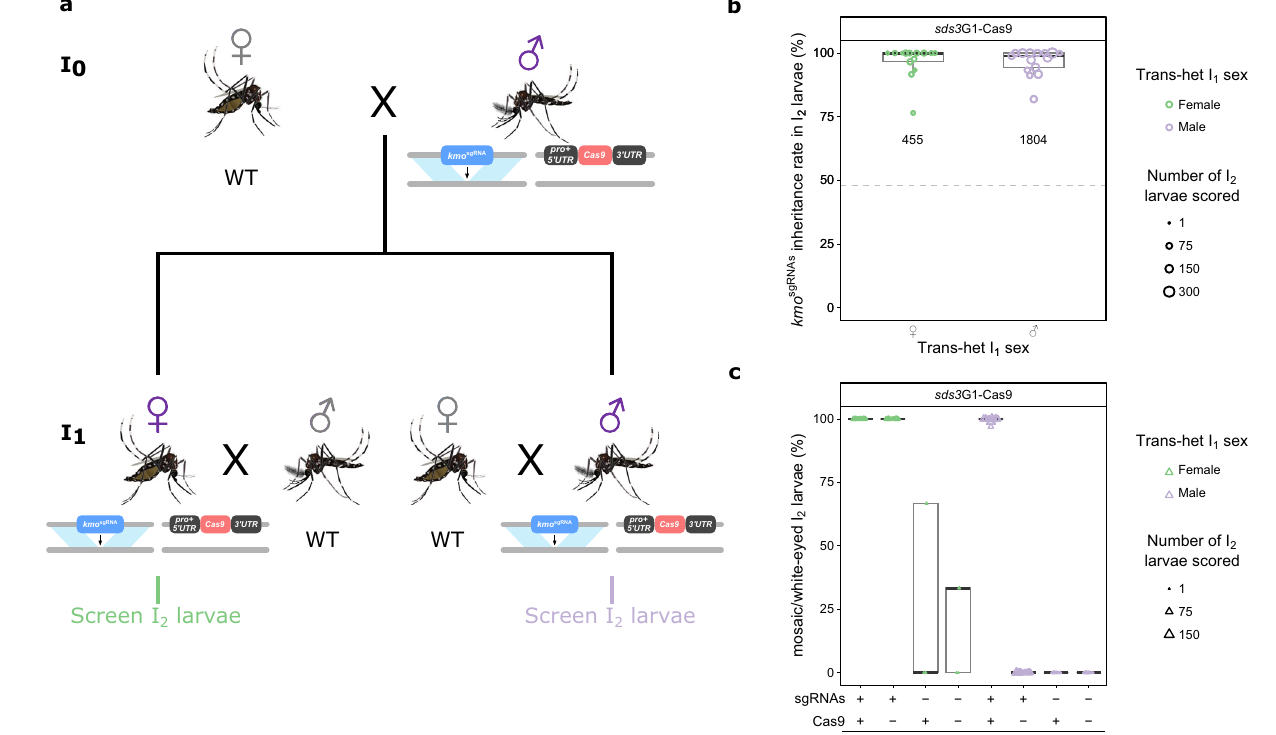
Fig. 3 | Drive characteristics of individual kmo sgRNAs ; sds3 G1-Cas9 trans-hetero- zygotes.a Crossing schemefordeterminationof sds3 G1-Cas9-inducedinheritance bias. b , c Boxplots of kmo sgRNAs inheritance ( b ) and eye phenotype ( c ) rates of I 2 larvae. The median value is indicated by a thick black line and the maximum and minimum ends of whiskers represent the most extreme data point that is no more